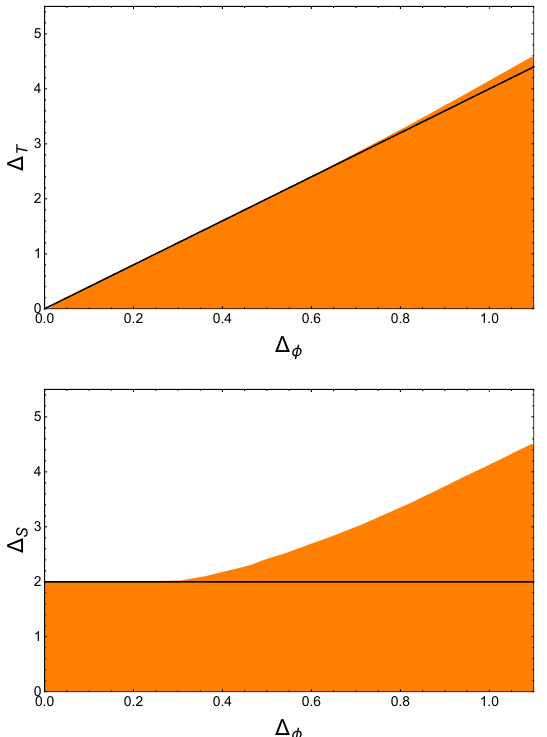
Figure 5: The numerical bounds for ∆ (the scaling dimension of the leading scalar T operator in the rank-2 symmetric traceless tensor representation of O ( 2 ) ) and ∆ scaling dimension of the leading scalar operator in singlet representation of O ( 2 ) ) for CFTs with O ( 2 ) symmetry in 2d. Shaded regions are consistent with bootstrap constraints, therefore allow unitary CFTs to exist. The solid line corresponds to 2d = 4 ∆ ∆ = free boson which has ∆ φ and T S